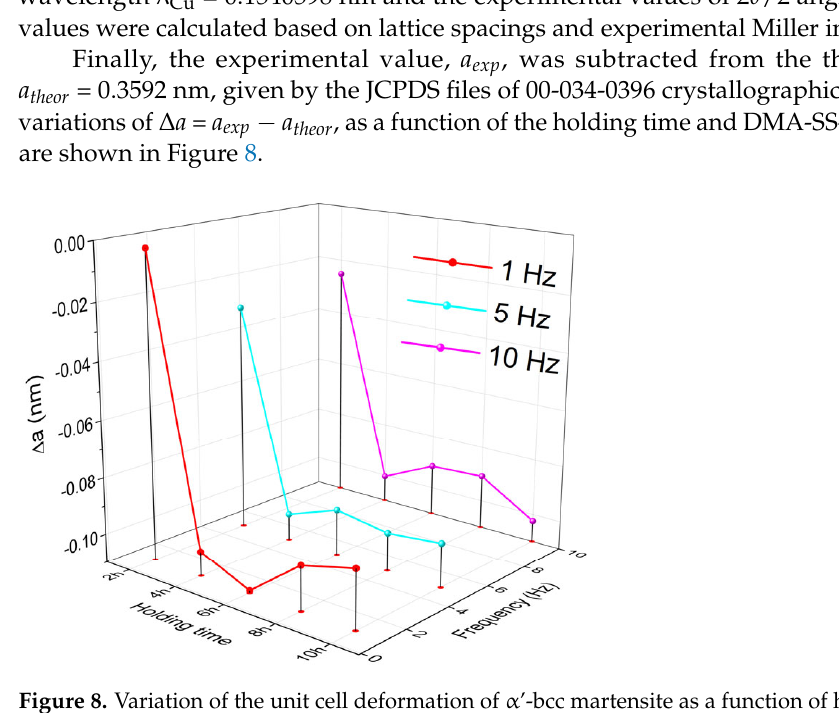
Figure 8. Variation of the unit cell deformation of α ’-bcc martensite as a function of holding time and DMA-SS-3PB frequency, according to the XRD patterns from Figure 7.